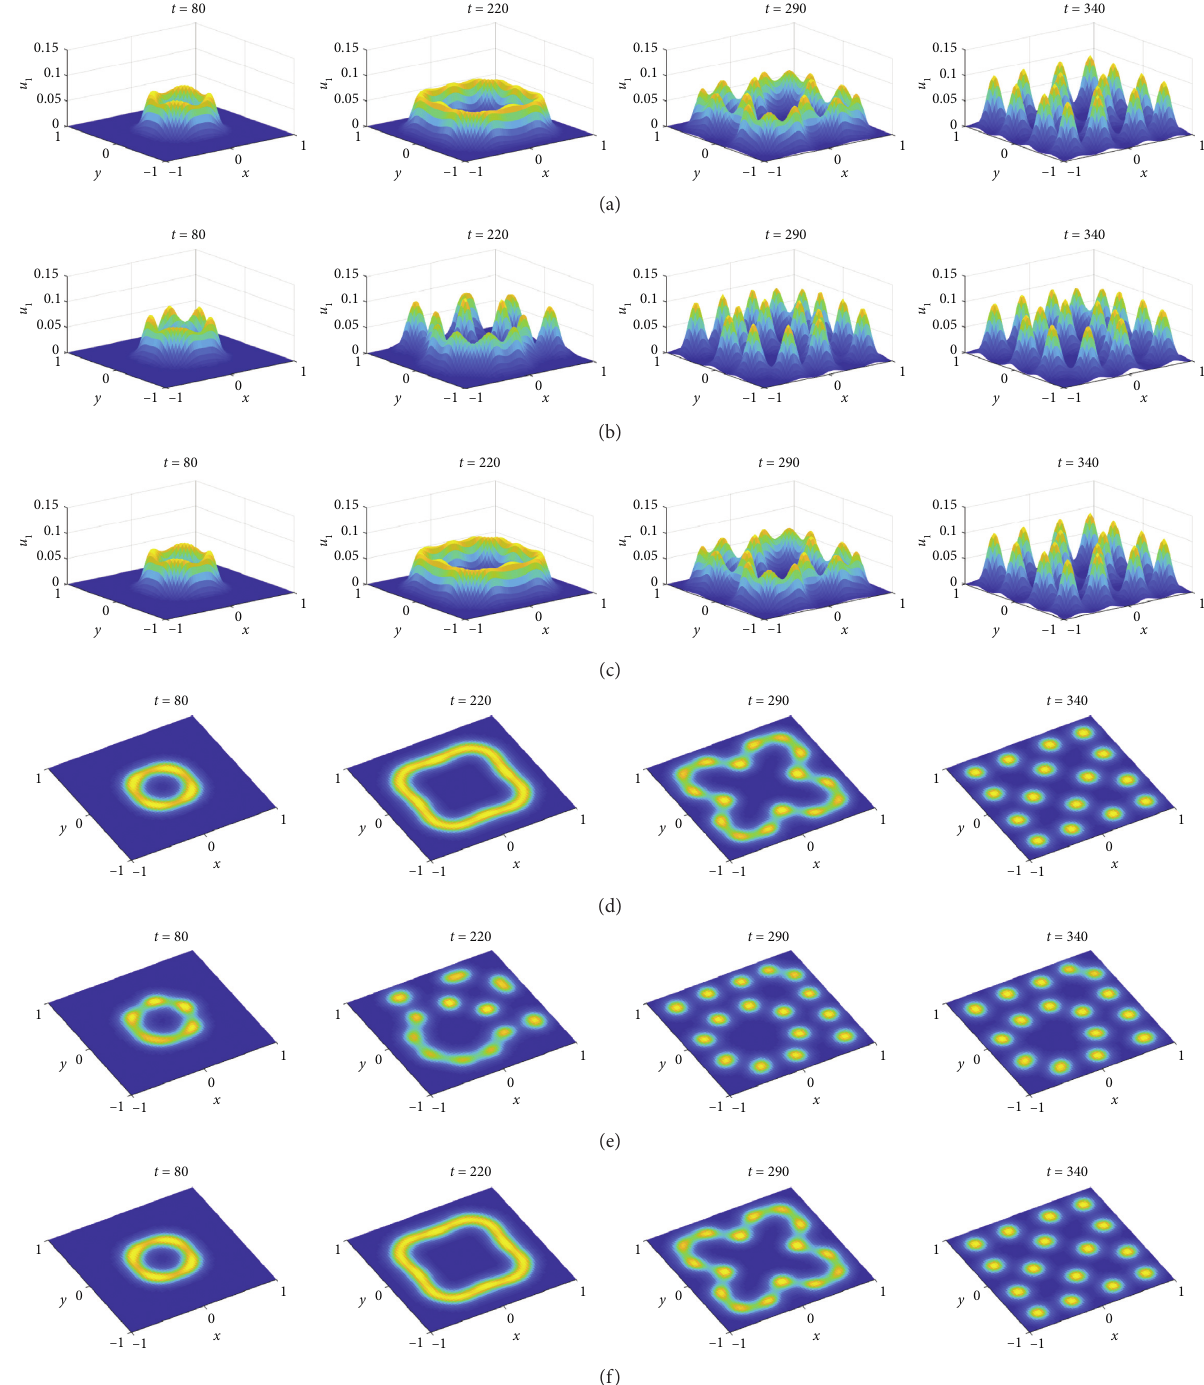
Figure 4: Numerical solutions for u of the Gierer–Meinhardt model at the spatial resolution Δ x � Δ y � 1/32: (a) the variable- θ 1